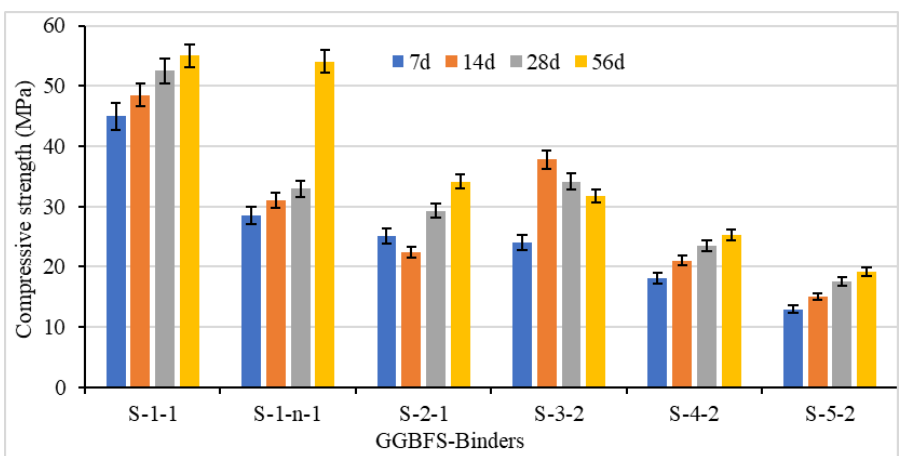
Figure 5. Influence of reagents (1 and 2) on GGBFS binders.